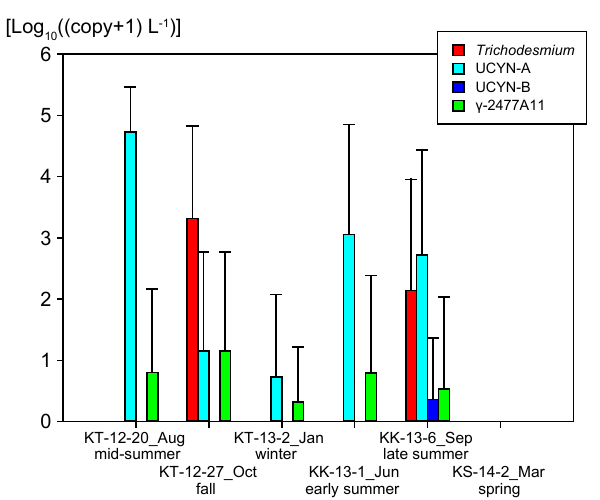
Figure 7. Average abundances of Trichodesmium (red), UCYN- A (light blue), UCYN-B (blue), and γ -24774A11 (green) [Log 10 ((copy + 1)L − 1 ) ] at the surface during each cruise. When the target nifH gene was not detected, the copy number was assumed to be